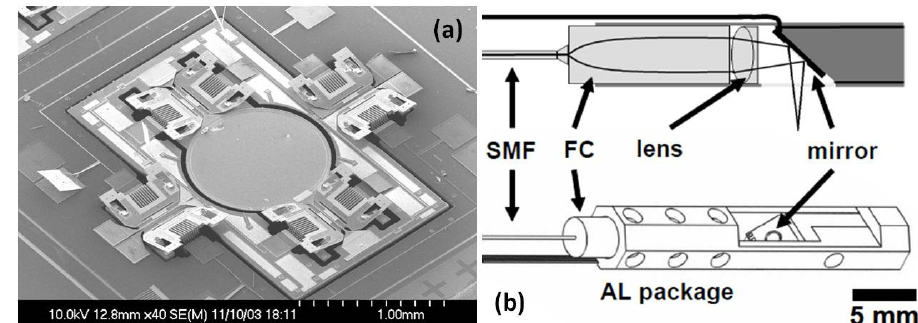
Figure 1. ( a ) Scanning electron micrograph of the MEMS two-axis optical scanner. The scanner has a large 1 mm diameter mirror and uses angled vertical comb (AVC) actuators to produce a large angle scan for high-resolution imaging. ( b ) Optical schematic and mechanical drawing of the optical coherence tomography (OCT) catheter endoscope. SMF: single mode fiber, FC: fiber collimator, AL: aluminum. Reproduced with permission from [28]; published by OSA, 2007.